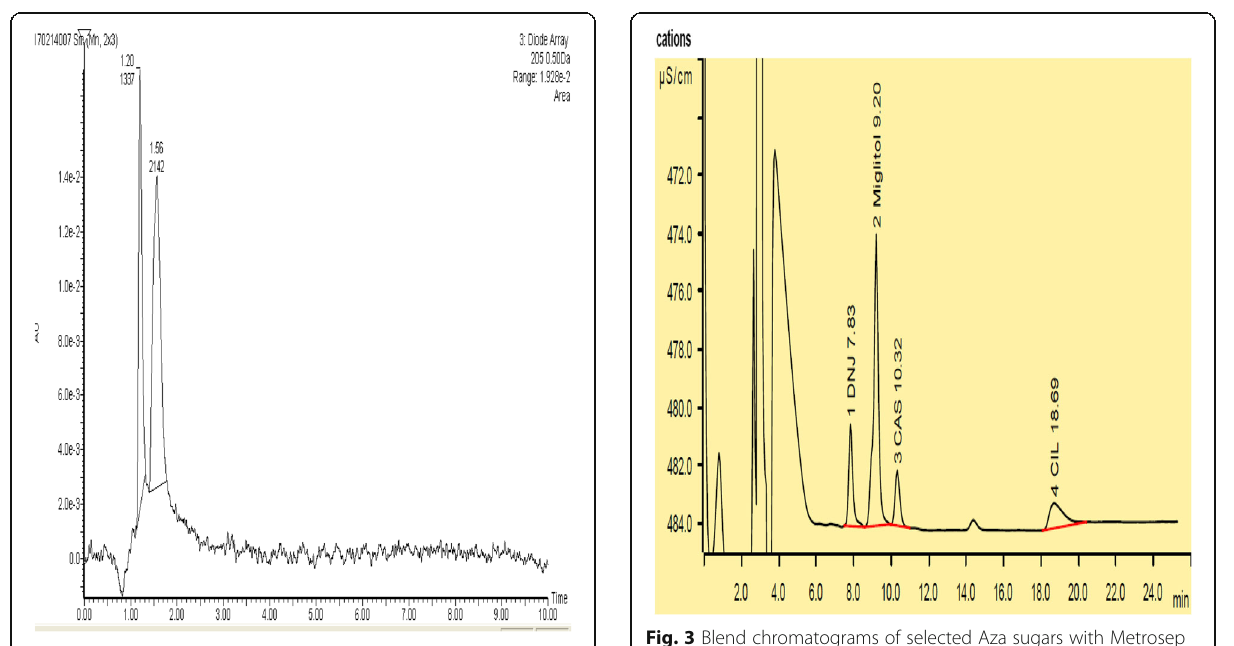
Fig. 1 UPLC method chromatogram of Aza sugars